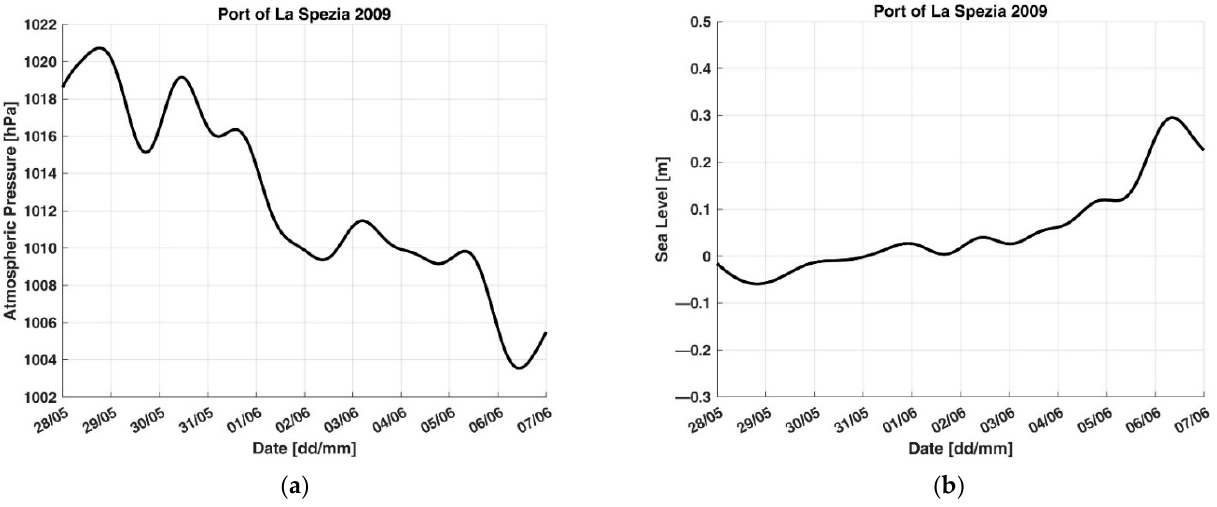
Figure 5. Measurements carried out between 28 May and 7 June 2009 inside the port of La Spezia, after Low-Pass filtering: ( a ) atmospheric pressure; ( b ) sea